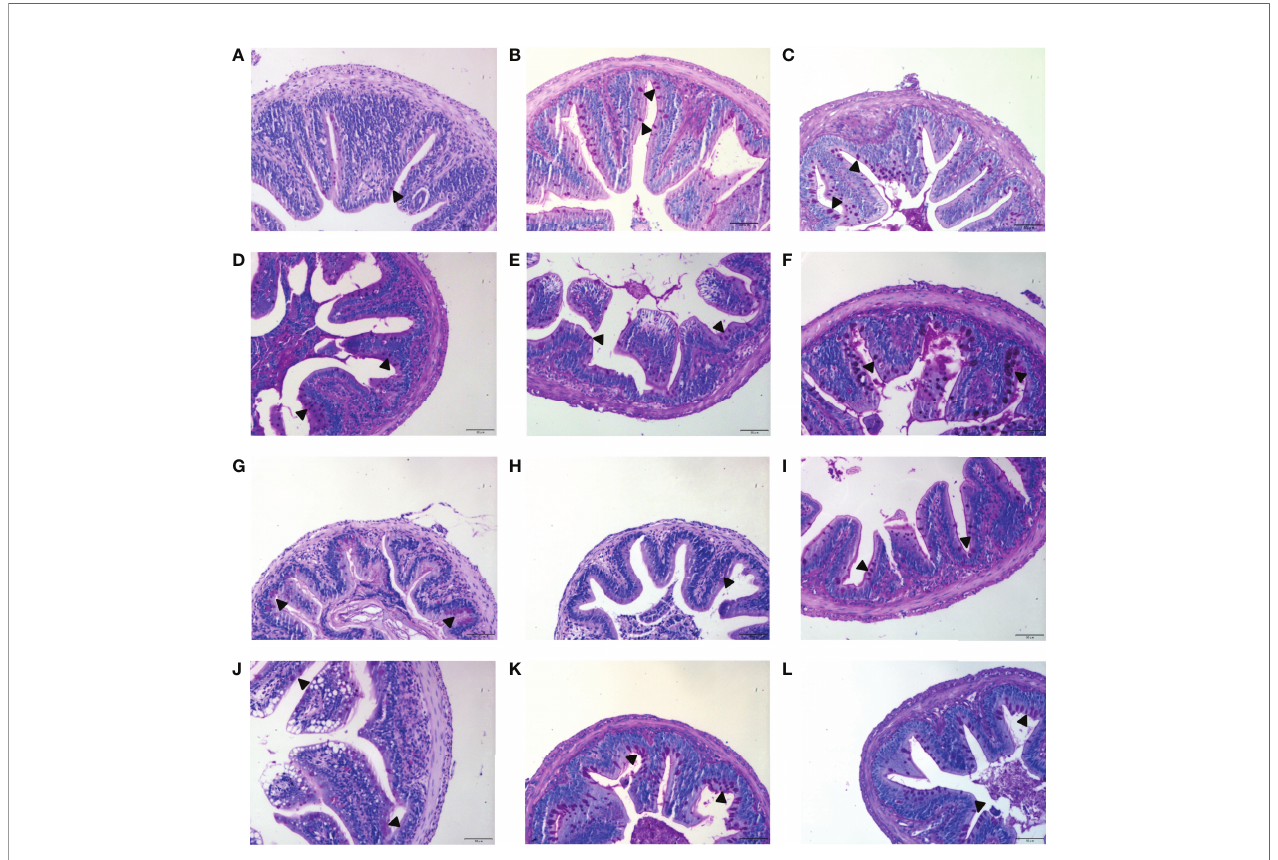
FIGURE 4 | Effects of MOS supplementation on the numbers of intestinal goblet cells by AB-PAS staining. (A – C) Mid-intestine sections of control, MOS200, and MOS400 groups at 0 hpi, respectively. (D – F) Sections at 12 hpi. (G – I) Sections at 24 hpi. (J – L) Sections at 72 hpi. Goblet cells were marked with triangle. Scale bars represented 50 µm (200×).